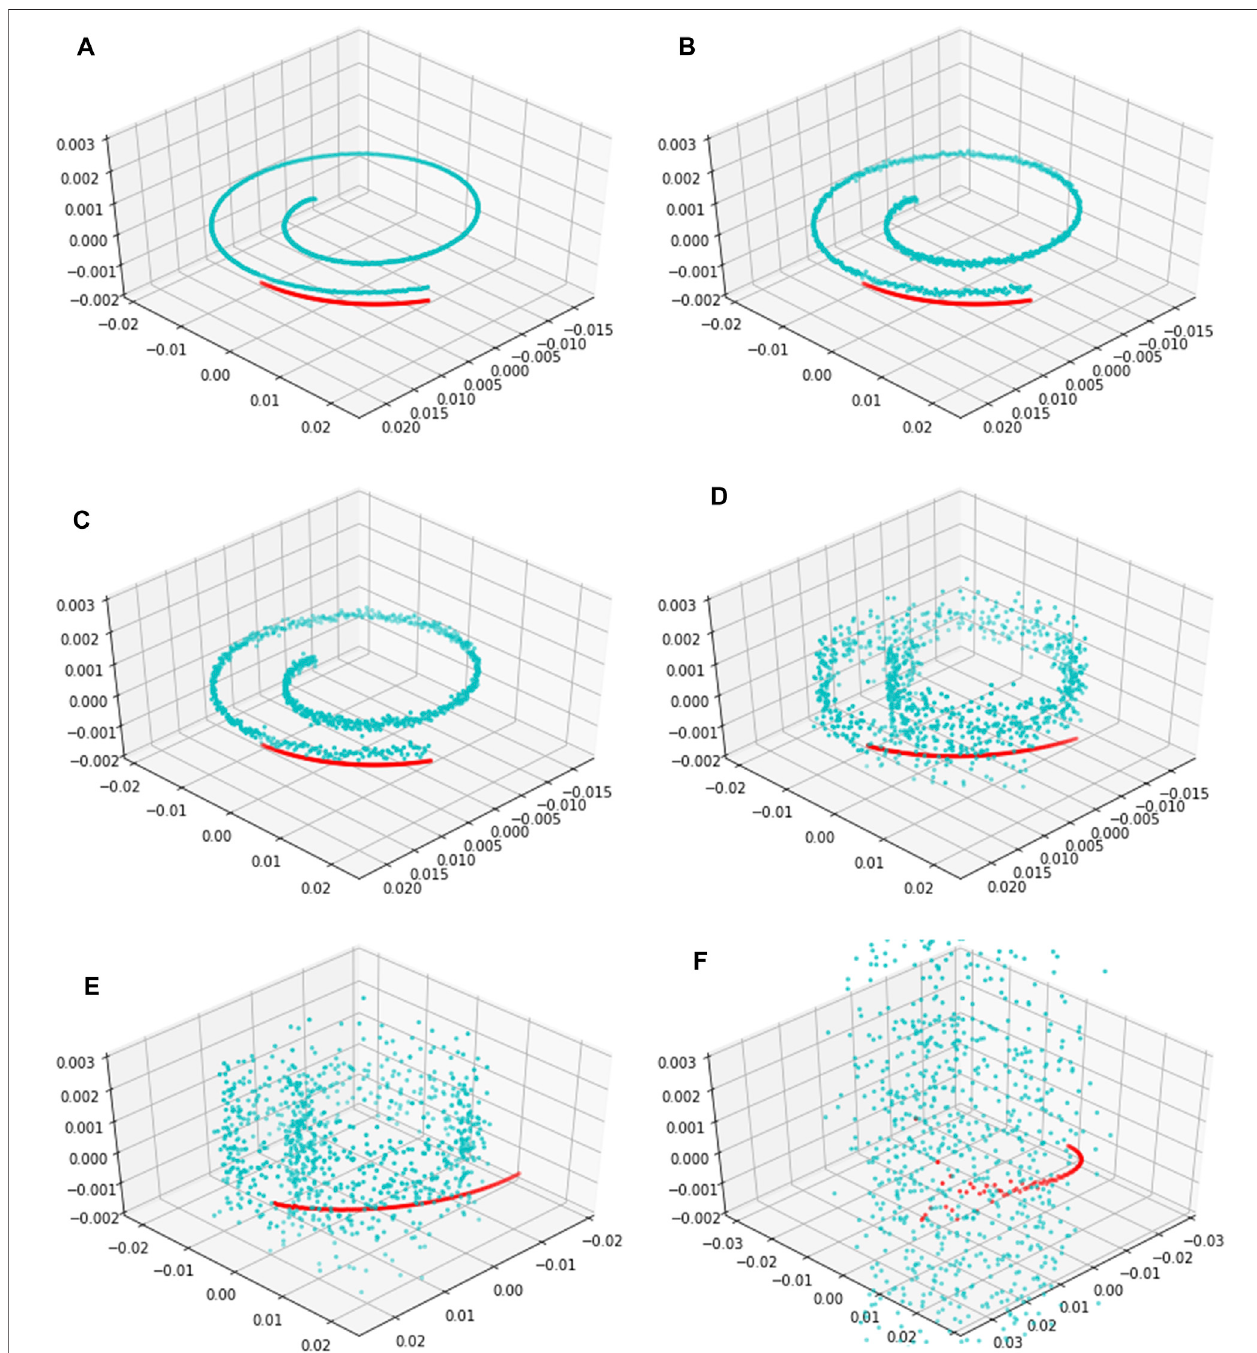
FIGURE7| ThepredictivetrajectoriesoftheEKATPwithin100stepsunderdifferentintensitiesofnoise.Cyandotsrepresenttruedatawithanintervalof t ∈ [0:900]. Red dots represent predictive data with an interval of t ∈ [800:900]. (A) σ (cid:1) 0.001. (B) σ (cid:1) 0.005. (C) σ (cid:1) 0.010. (D) σ (cid:1) 0.050. (E) σ (cid:1) 0.100. (F) σ (cid:1) 0.500.